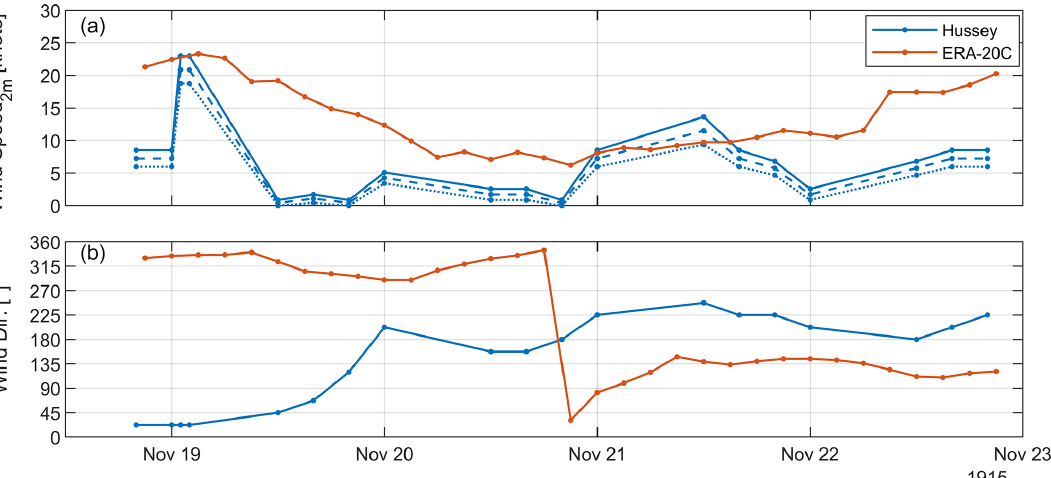
Figure 4. Time series comparison of wind speeds (a and directions (b) between recordings from Hussey and the ERA-20C product. For the Hussey wind speeds (since Hussey reported Beaufort indices), the solid (dotted) line indicates wind speeds corresponding to the upper (lower) Beaufort index bound. The dashed line shows the mean for that